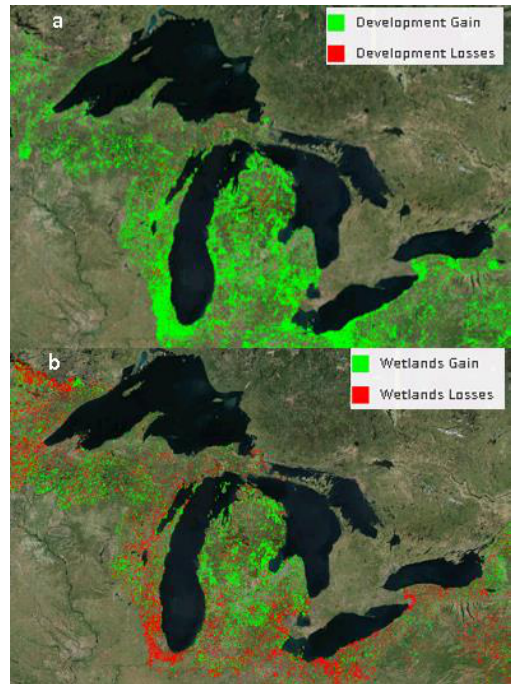
Figure 2: a) Gains and losses in land cover classified as developed from 1996 to 2010. b) Gains and losses in land cover classified as wetlands from 1996 to 2010. Data comes from NOAA’s C-CAP Land Cover Atlas online data viewer.